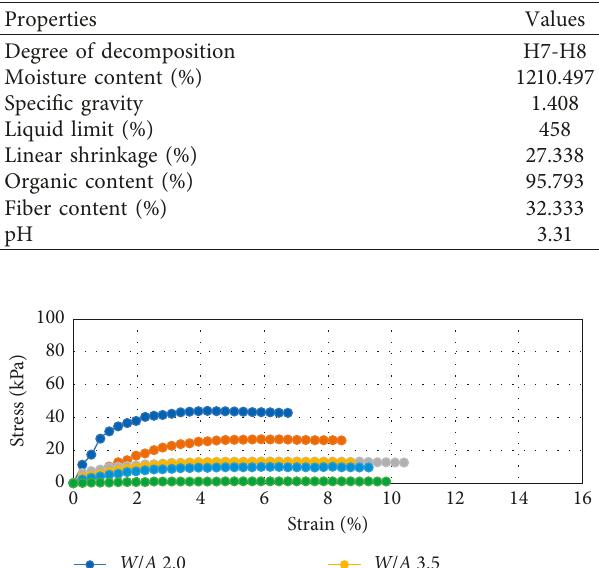
Table 3: Physical properties of Kampung Meranek peat.